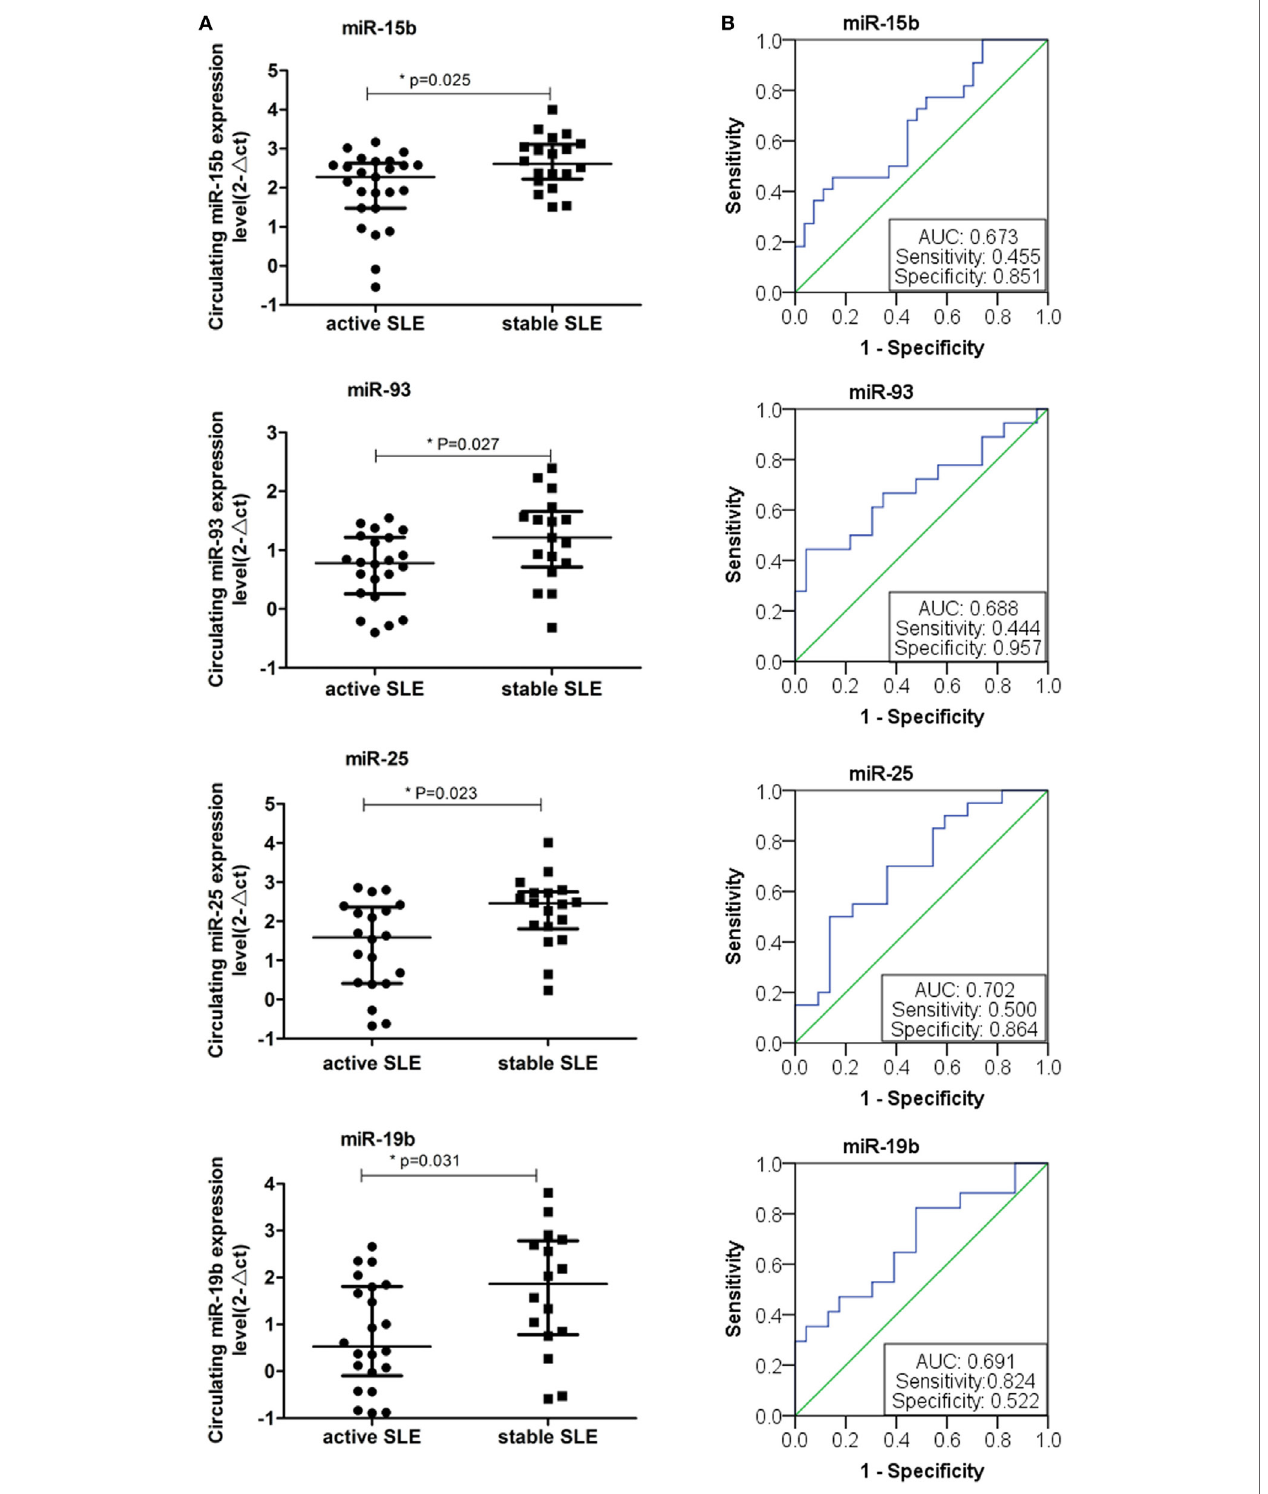
FigUre 5 | Expressions of four plasma microRNAs (miRNAs) in patients with active systemic lupus erythematosus (SLE). (a) Four plasma miRNAs expressed differentially in the active SLE and stable SLE patients. Expressions of selected miRNAs in the plasma obtained from patients with SLE ( n = 50) were determined by RT-qPCR. The expression levels of miRNAs were normalized to cel-miR-39. (B) Receiver operating characteristic curve analysis of four plasma miRNAs expressed in the active SLE and stable SLE